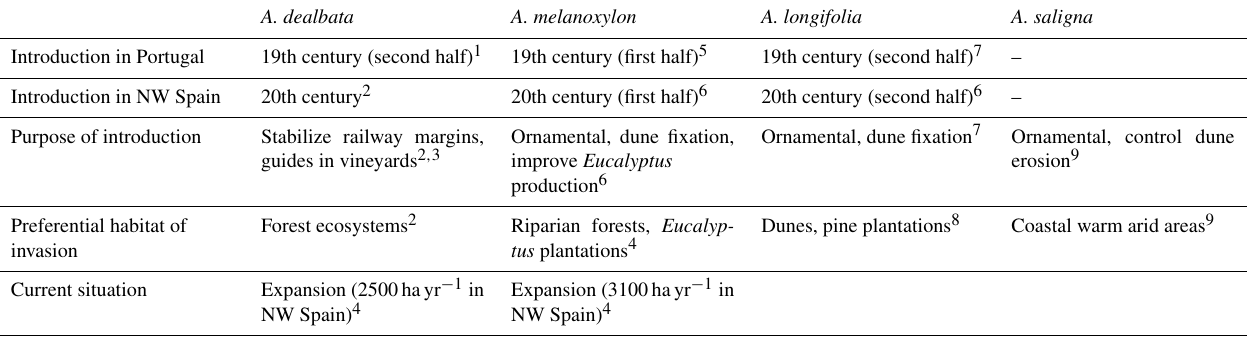
Table 2. Invasive Australian acacias in western Iberia: date and purpose of the introduction, habitats preferentially invaded, and current situation.